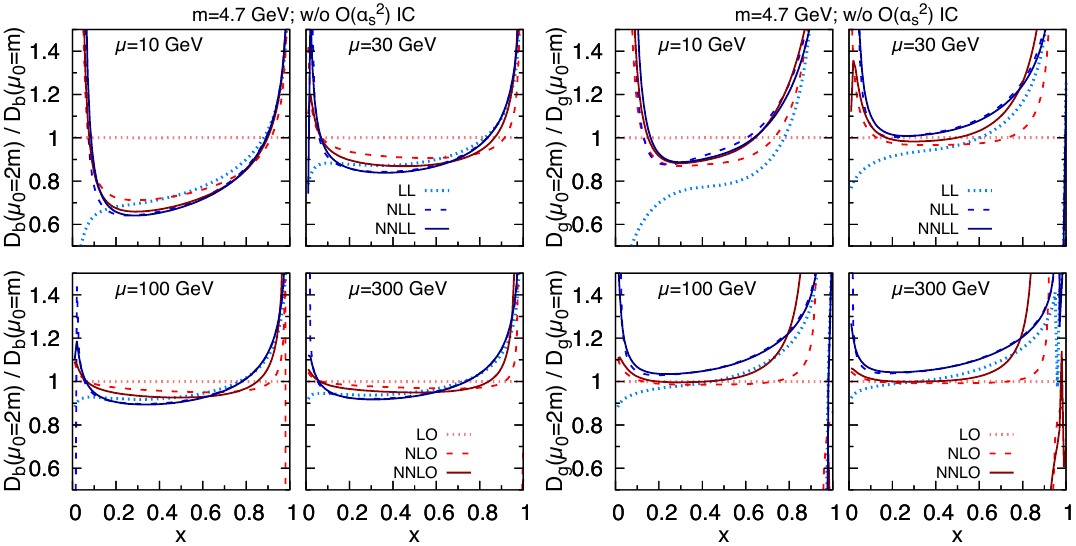
Figure 5 . The ratio D p ( (cid:22) 0 = 2 m ) =D p ( (cid:22) 0 = m ) in x space, with p = b; g in the left and right panels respectively, computed at di(cid:11)erent orders for the truncated solution (LO, NLO, NNLO) and resummed solutions (LL, NLL, NNLL). Four values of the factorisation scale (cid:22) are considered in each panel: (cid:22) = 10 ; 30 ; 100 ; 300